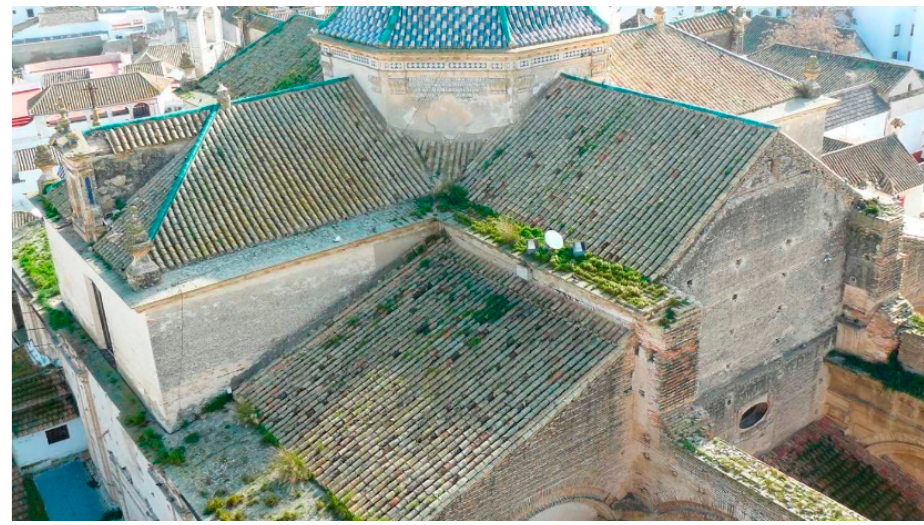
Figure 5. Previous state of the roofs at the beginning of the repairs works due to the absence of maintenance access.